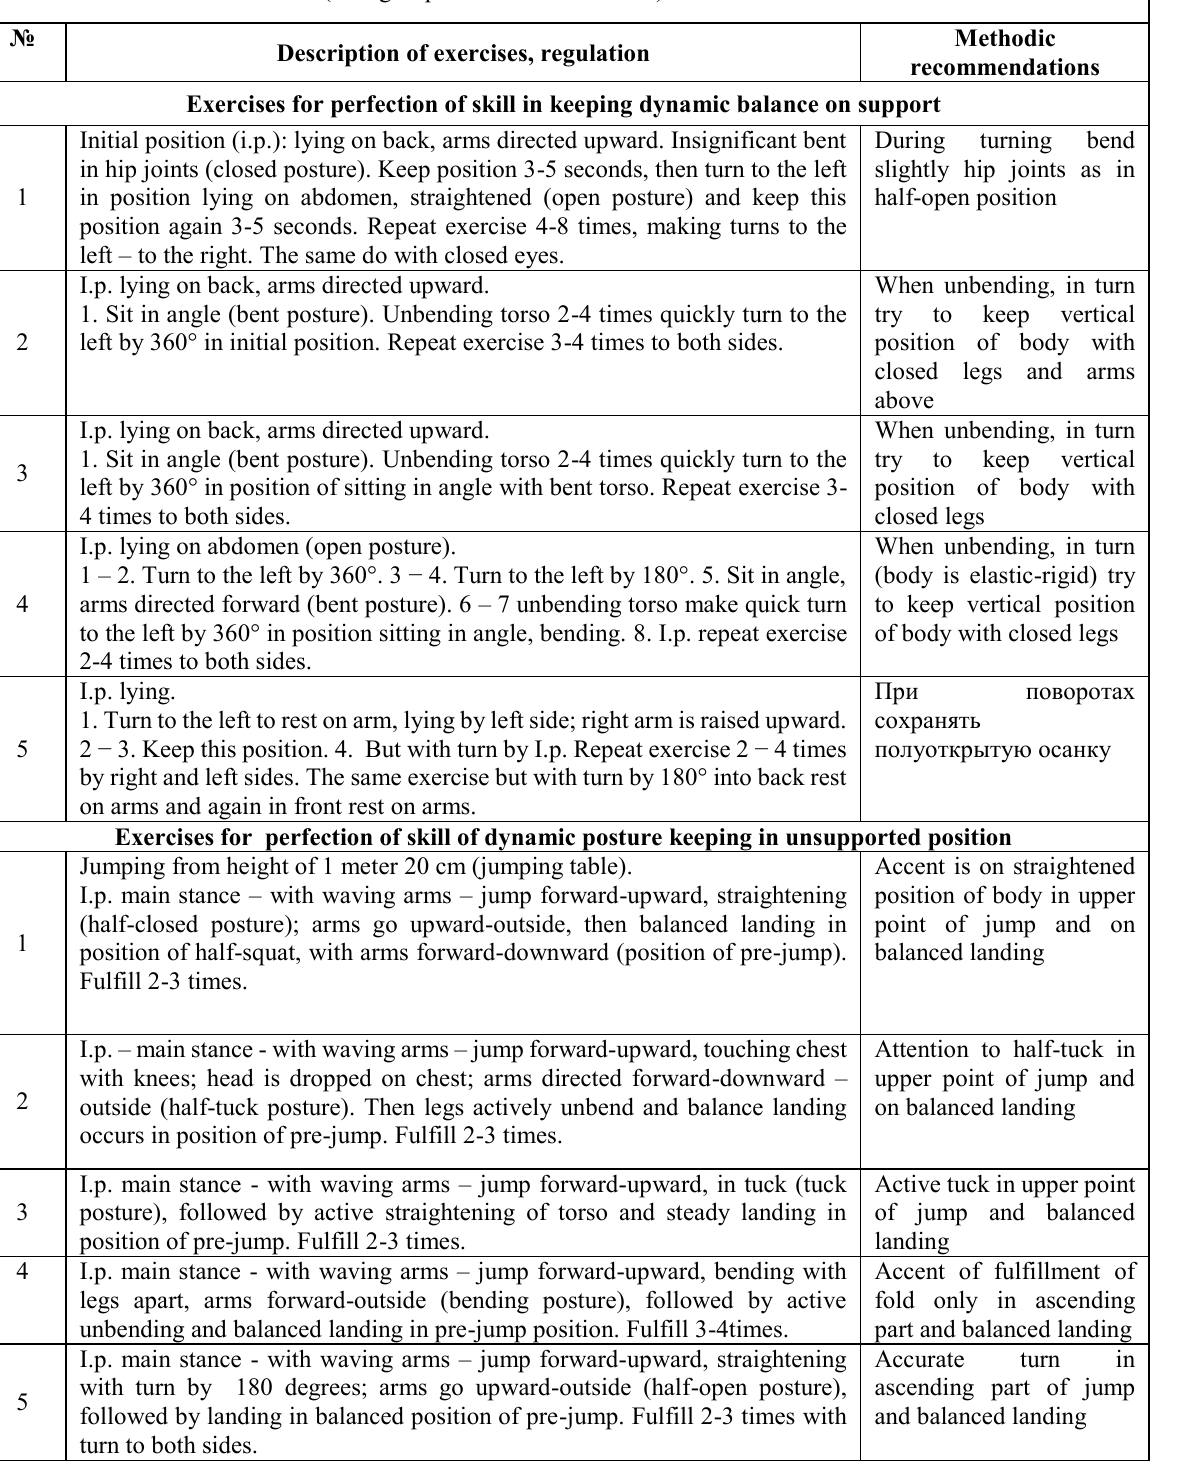
Exercises of program “Coordination training” of first year students of NUPESU, specializing in sport gymnastic Part 1 Training of static-dynamic